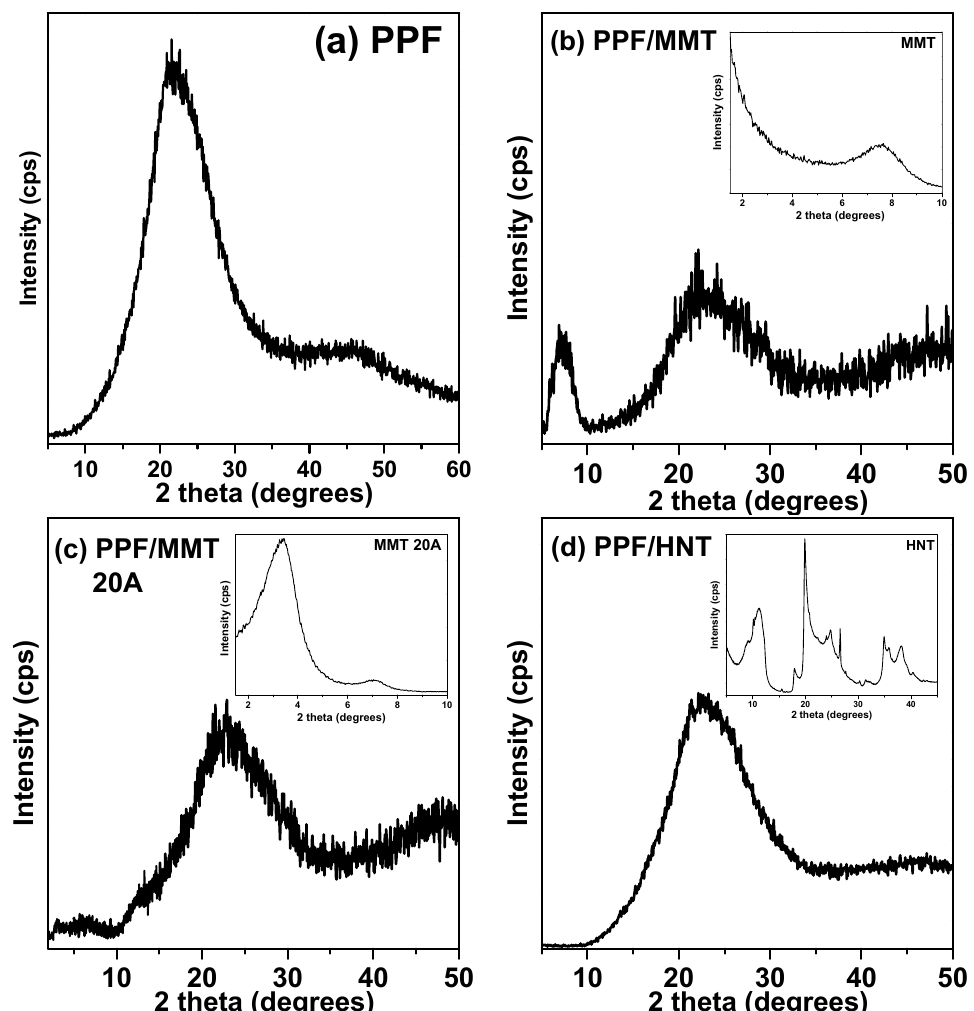
Figure 3. WAXD patterns of the nanofillers and their nanocomposites with PPF.